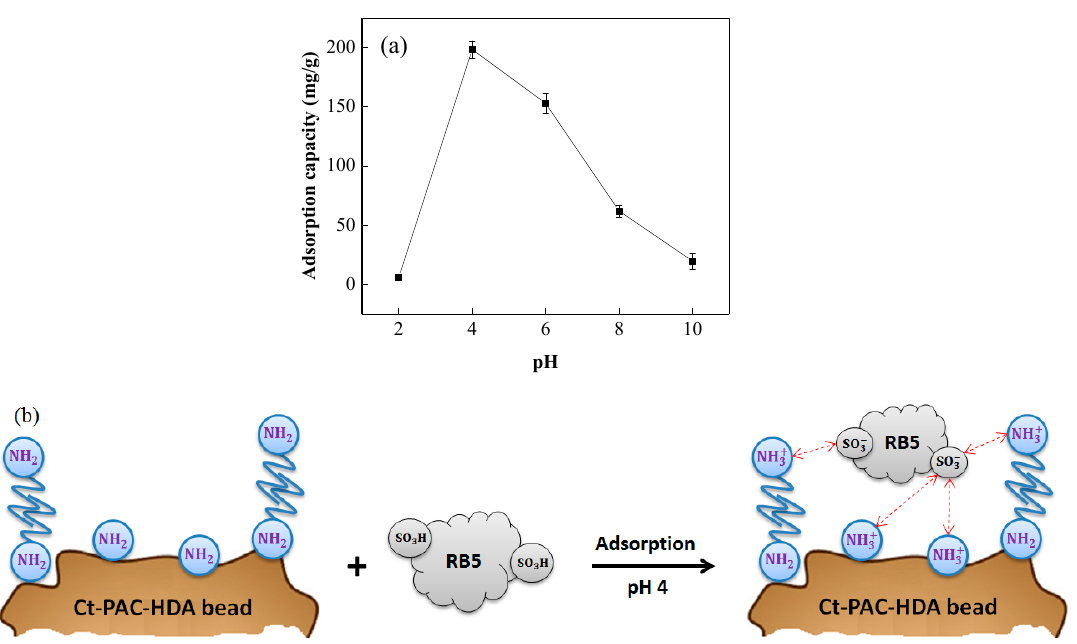
Figure 5. ( a ) Effect of pH on the adsorption of RB5 using Ct-PAC-HDA beads (30 mg of beads, 200 Figure 5. ( a ) E ff ect of pH on the adsorption of RB5 using Ct-PAC-HDA beads (30 mg of beads, 200 mL mL of 50 mg/L of RB5, 25 °C, 24 h) and ( b ) schematic diagram of the RB5 adsorption mechanism by of 50 mg / L of RB5, 25 ◦ C, 24 h) and ( b ) schematic diagram of the RB5 adsorption mechanism by Ct-PAC-HDA beads. Ct-PAC-HDA